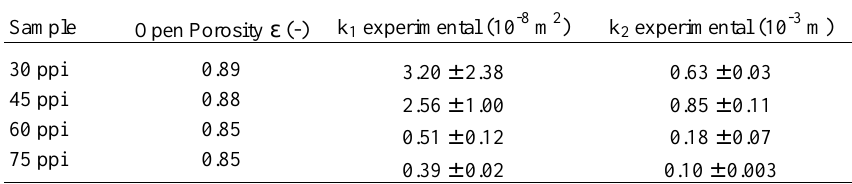
Table 1. Experimental values of porosity and permeability constants for samples analyzed in this work.